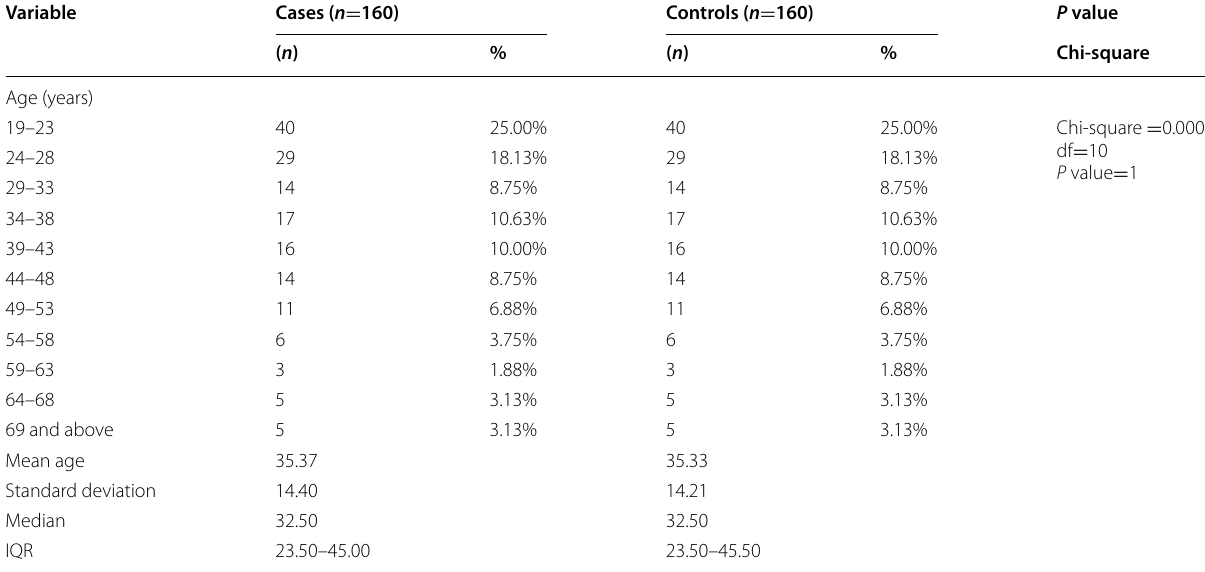
Table 1 Age wise distribution of participants